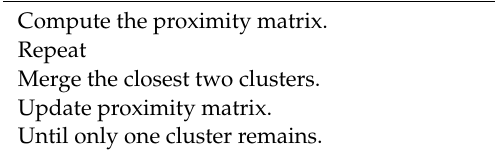
Algorithm 1 Hierarchical Clustering